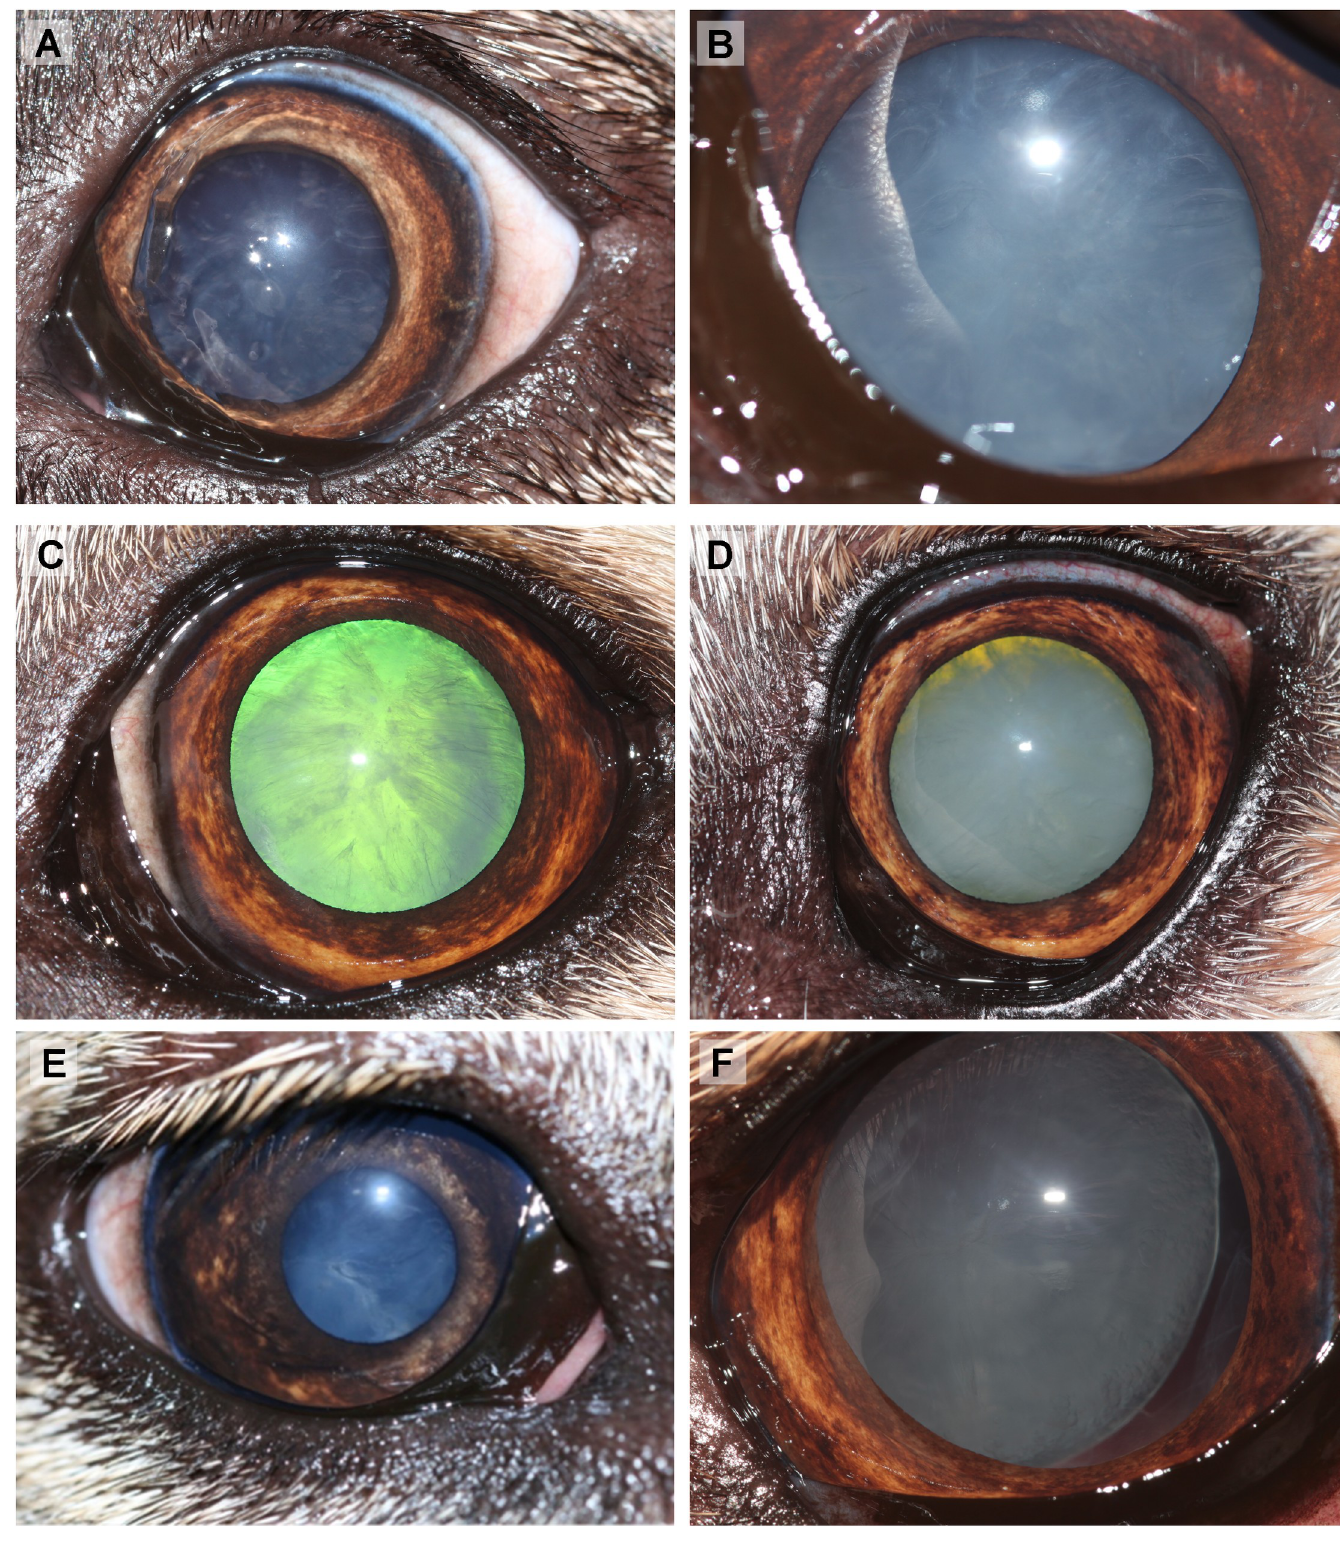
Fig 5. Progression of ocular lesions in oculoskeletal dysplasia (OSD)-affected Northern Inuit Dogs NID. In the left eye of Dog 1, immature cataract (A) progression associated with lens induced uveitis presented as iridal hyperpigmentation (B). In the left eye of Dog 5, an immature cataract (C) progressed to an advanced immature cataract (D). In the right eye of Dog 4, immature cataract (E) progression was associated with lens induced uveitis, and posterior lens subluxation was also observed (F). https://doi.org/10.1371/journal.pone.0220761.g005 PLOS ONE | https://doi.org/10.1371/journal.pone.0220761 August 15,